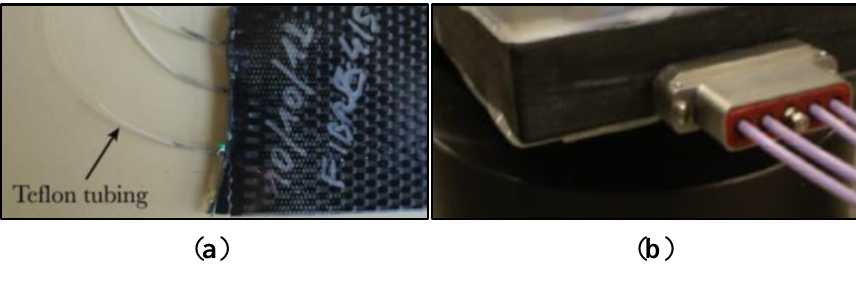
Figure 8. Teflon tubes ( a ) [94] and embedded connector ( b